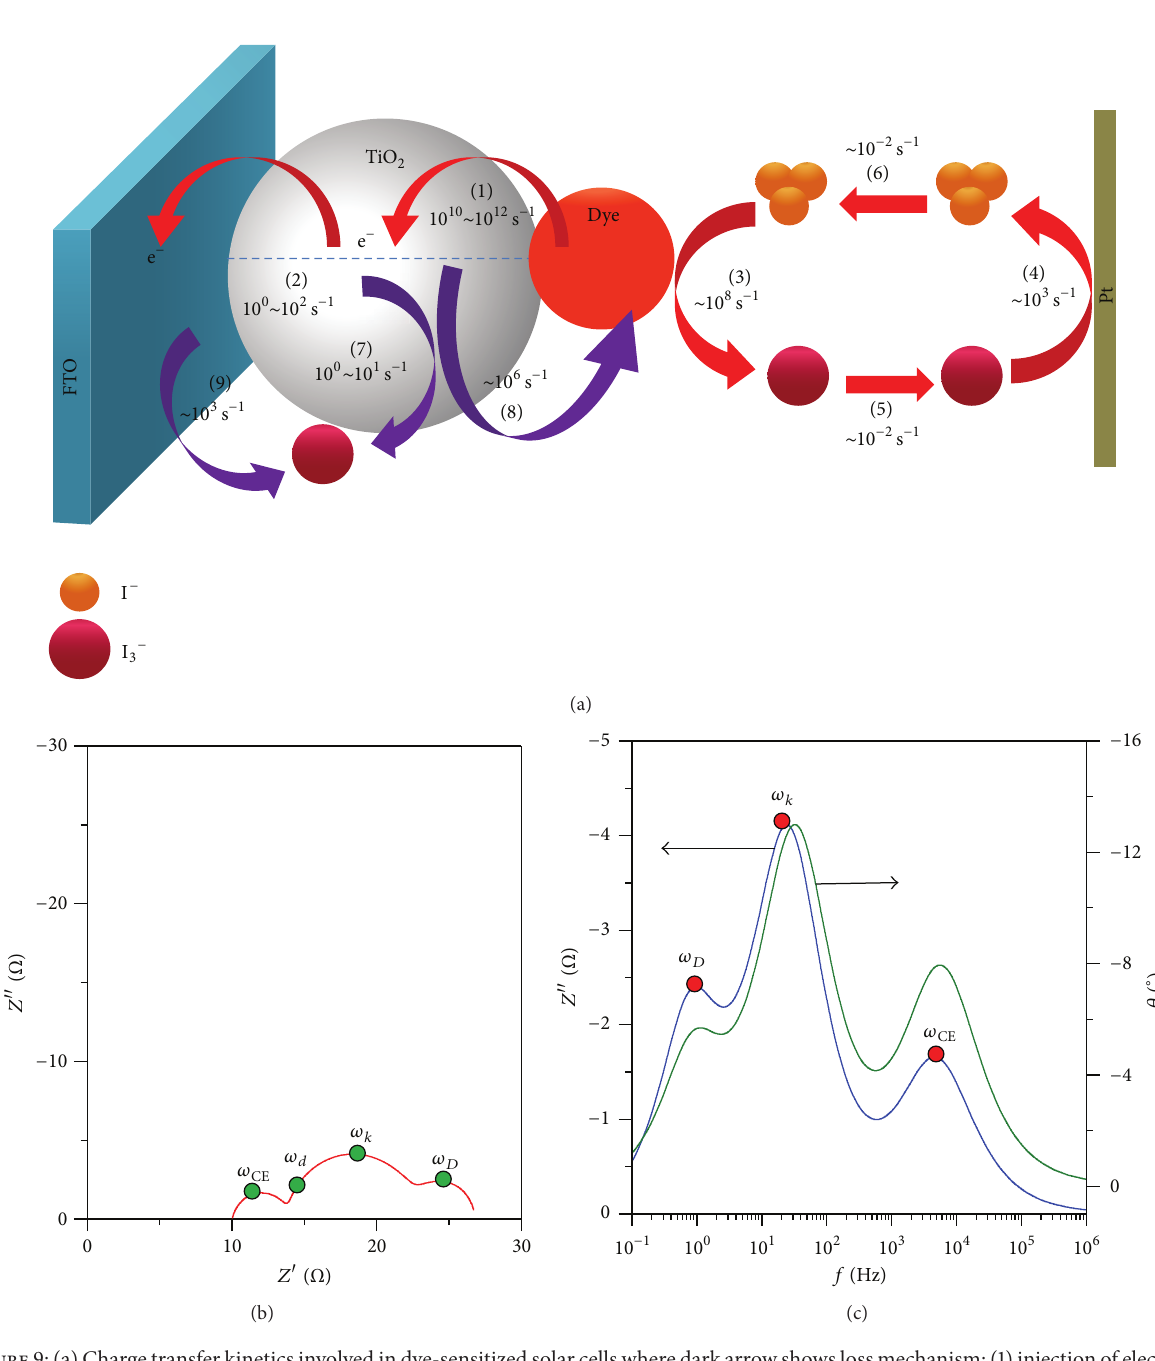
, 𝜔 𝑑 , 𝜔 𝑘 , and 𝜔 𝐷 correspond to the CE